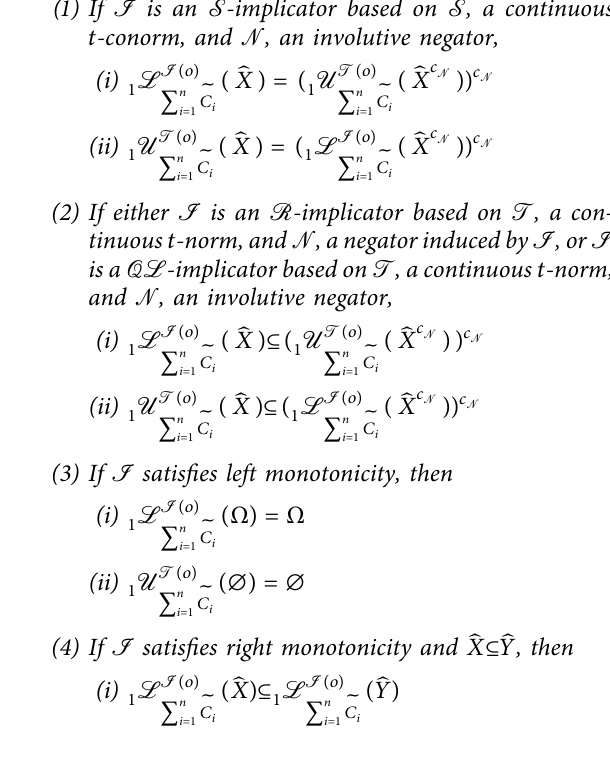
Table 4: Table for 􏽥 N β